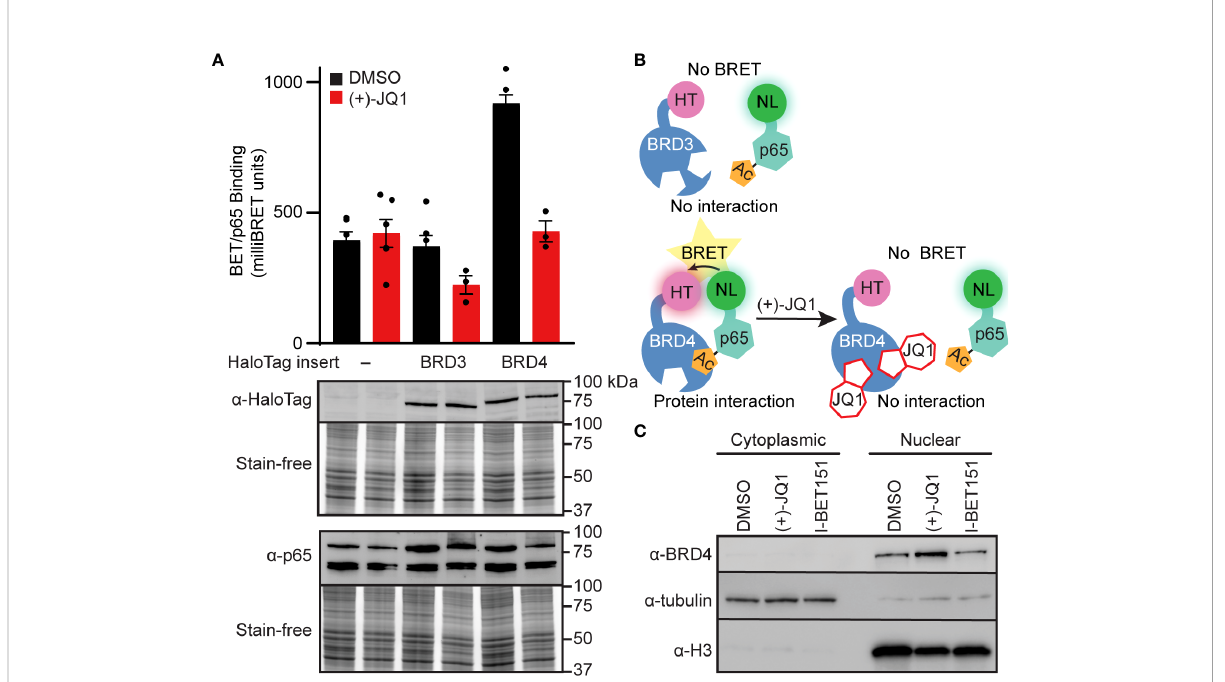
FIGURE 3 BET bromodomain inhibitors disrupt BRD4-p65 interaction. (A) NanoBRET assays completed in INS 832/13 cells transfected with Halo-tagged BET tandem bromodomains and nanoluciferase-tagged p65 exposed to 1 m M (+)-JQ1 or DMSO before BRET intensity reading. Expression blots show relative amounts of transfected proteins. (B) Schematic interpretation of NanoBRET results. (C) Immunoblot with an antibody directed against BRD4 in INS 832/13 cell fractions after 4-hour exposure to 0.5 m M (+)-JQ1, 1 m M I-BET151, or DMSO. Error bars for nanoBRET assay represent the standard error of the mean (SEM) from 3-6 individually plated wells per treatment